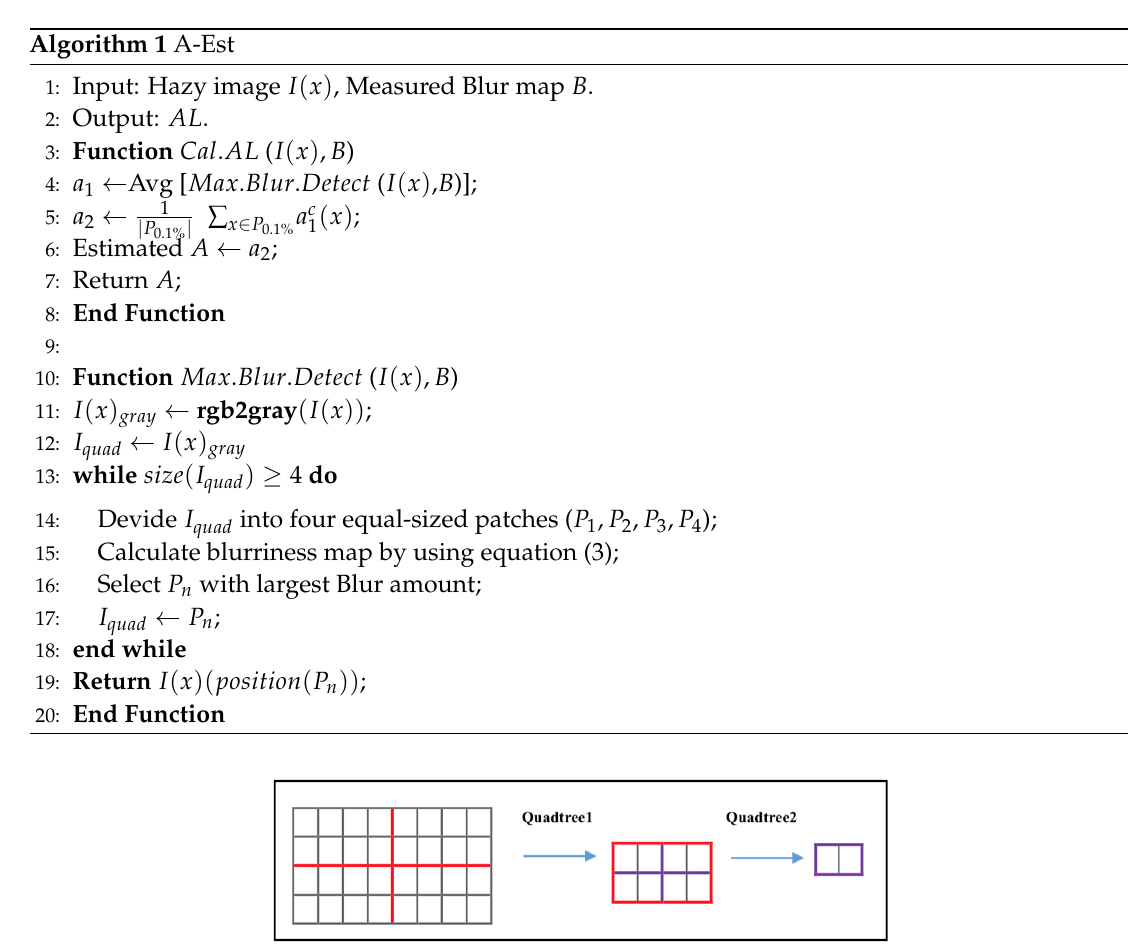
Figure 3. Overview of quadtree